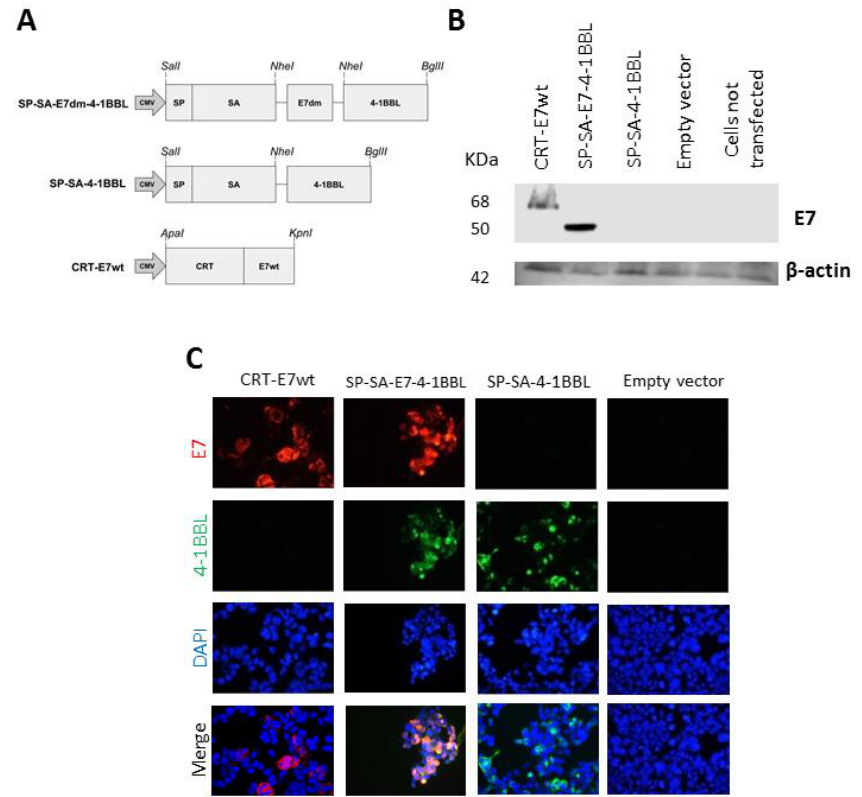
Figure 1. Design of DNA constructs and expression in HEK-293 cells: ( A ) Schematic of DNA constructs used in this study. This scheme shows the arrangement of streptavidin (SA), double mutant form of HPV-16 E7, and the extracellular domain of mouse 4-1BBL. A signal peptide (SP) was fused to the N-terminus of the recombinant genes. The controls were CRT-E7wt and empty plasmid. ( B ) A representative image of western blot analysis. 5 × 10 5 HEK-293 cells were transfected with constructs expressing CRT-E7wt, SP-SA-E7-4-1BBL, SP-SA-4-1BBL, and empty vector as negative control. Twenty-four hours later, cells were lysed, and protein expression was analyzed by western blot using E7 antibody. ( C ) Immunofluorescent staining of transfected HEK-293 cells. HEK-293 cells were transfected with constructs expressing CRT-E7wt, SP-SA-E7-4-1BBL, SP-SA-4-1BBL, and empty vector as negative control. Twenty-four hours later, cell slides were fixed and incubated with E7 and 4-1BBL antibodies, and the specific secondary antibodies conjugated with fluorochromes. Evaluation of DNA construct expression was performed by fluorescence microscopy. Images were taken at 40× magnification, DAPI was used as a marker for nuclei. DAPI, 4 ′ ,6-diamidino-2-phenylindole; CMV, cytomegalovirus promoter; CRT, calreticulin; SP, signal peptide.